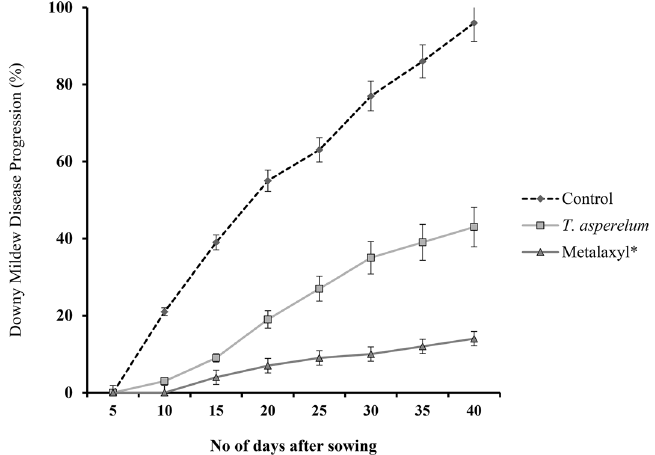
Figure 8. Effect of T. asperellum (DL-81) treatment against downy mildew disease of pearl millet under field conditions. Values ± SE (standard error) is means of three independent replicates.